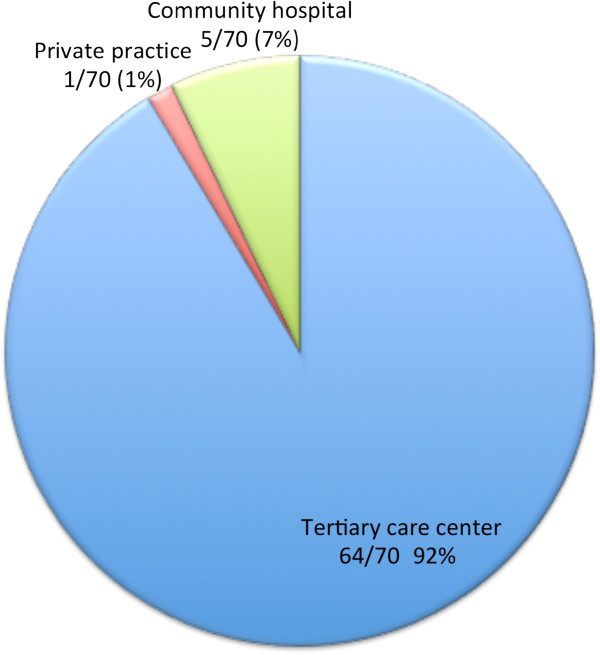
 Practice setting of respondents. The majority 92% practice in “tertiary care centers”, with 7% practicing in “community hospitals” and 1% in “private practice”.